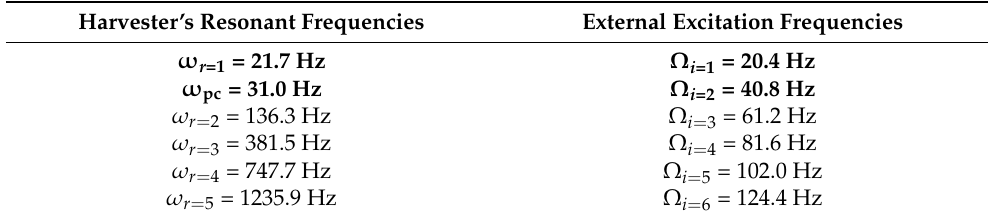
Table 6. Comparison of the harvester’s resonant frequencies and the external excitation harmonic